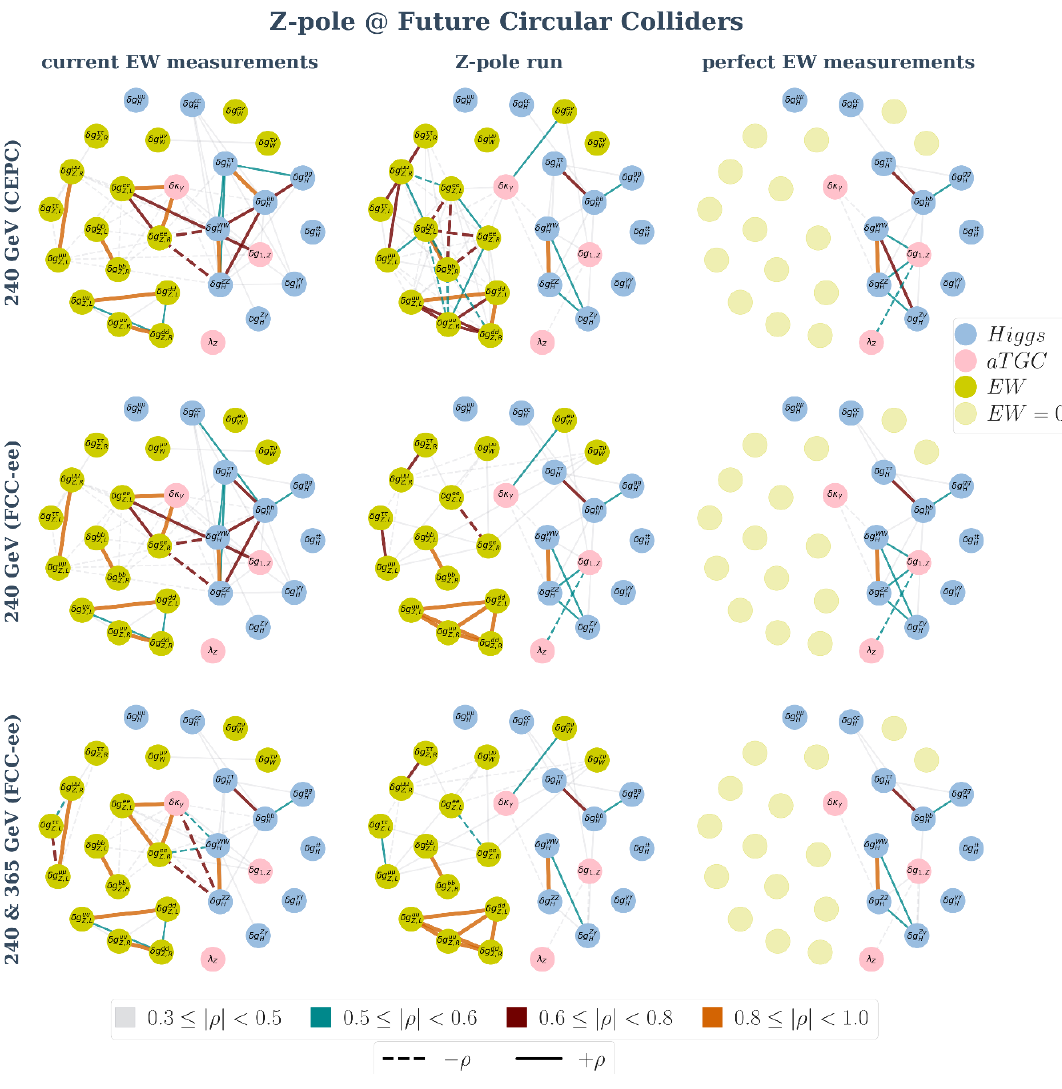
Figure 12 . Changes in correlations between couplings depending on the precision of EW mea- surements assumed. The top row is for CEPC and the bottom two rows are for FCC-ee. HL-LHC projections are included for all